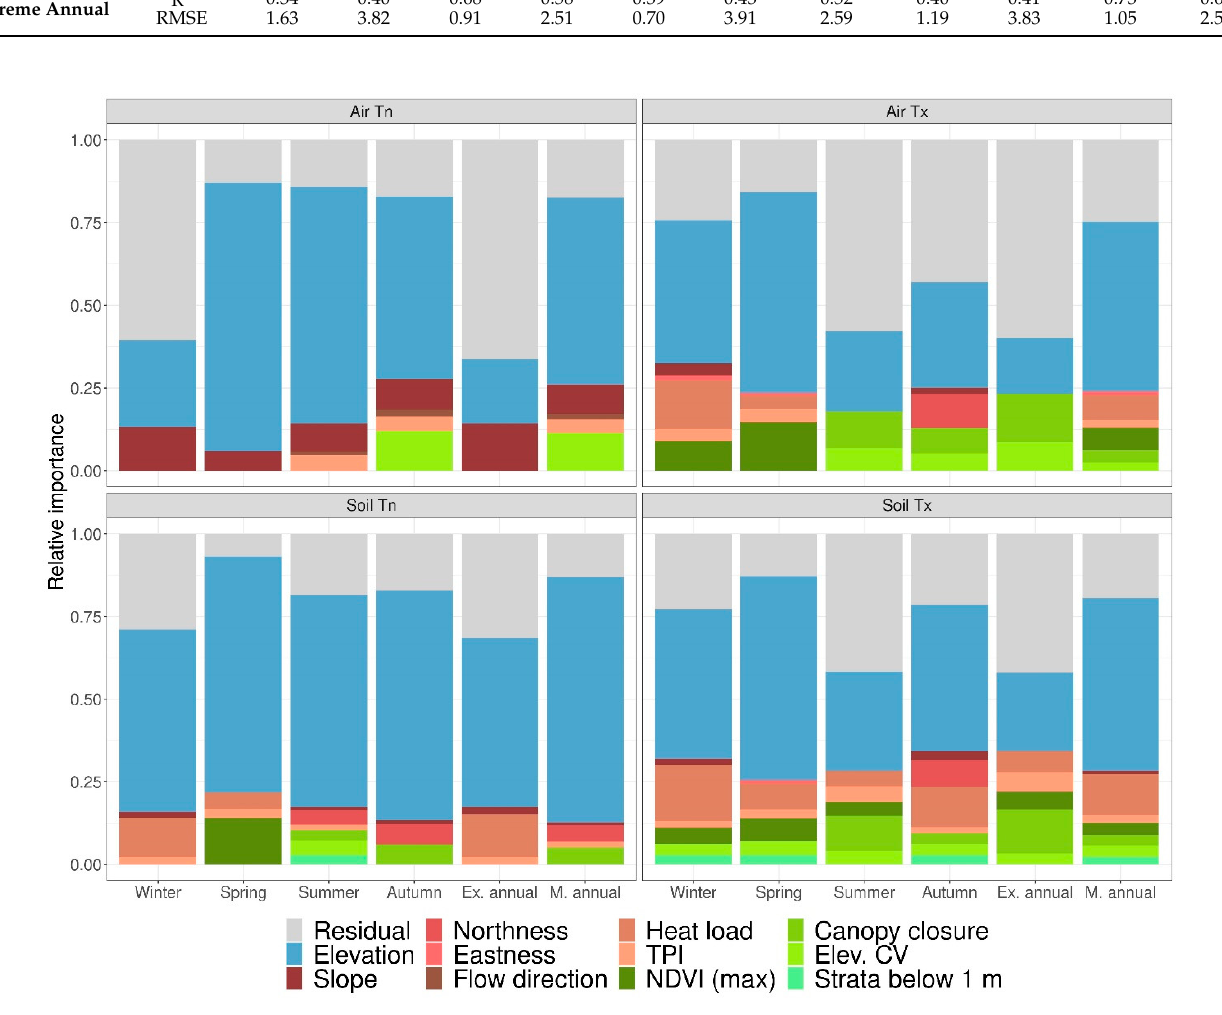
Figure 5. Relative importance of explanatory variables for modeling Tn and Tx recorded by in situ sensors in the air and on the ground over the 2100 m altitude of the PNOMP. The columns correspond to one of the six models: the four seasons, the annual extreme (Ex. annual), and the annual mean (M. annual).